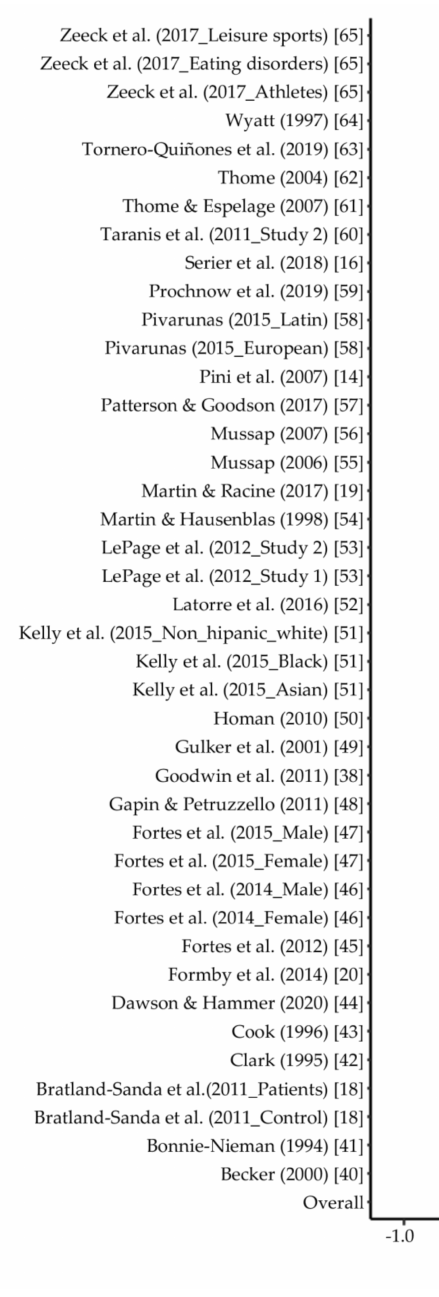
Figure 2. Forest plots of relationship between MEB and body